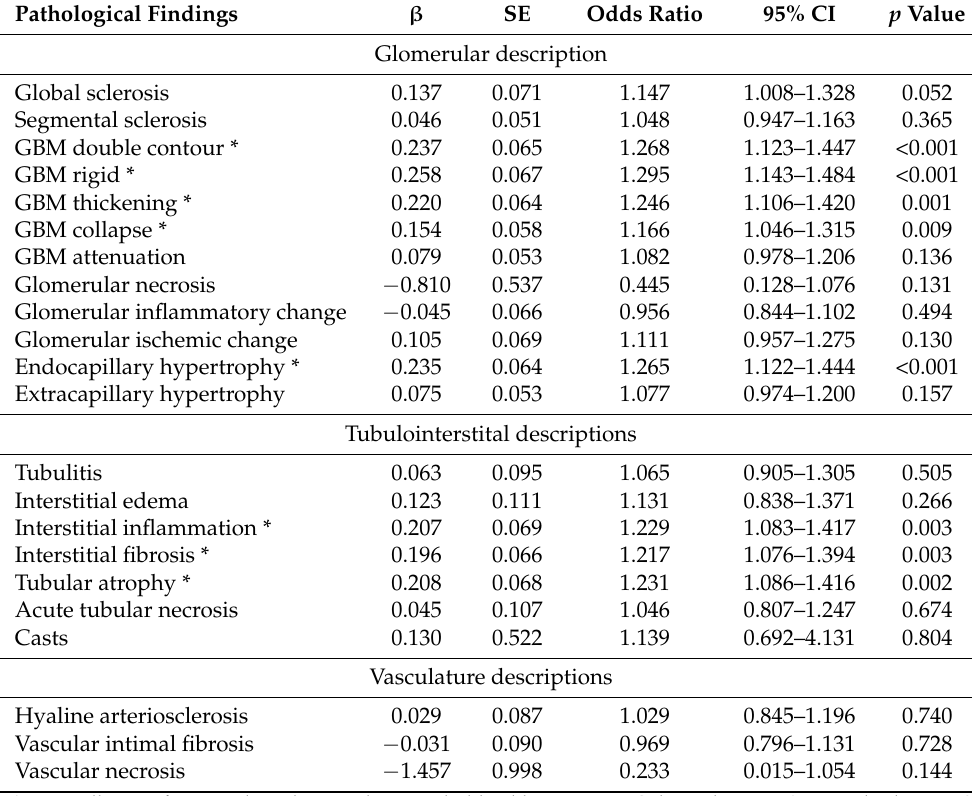
Table 4. Logistic regression for urinary Gal-3 (per 100 pg/mL) and renal pathological